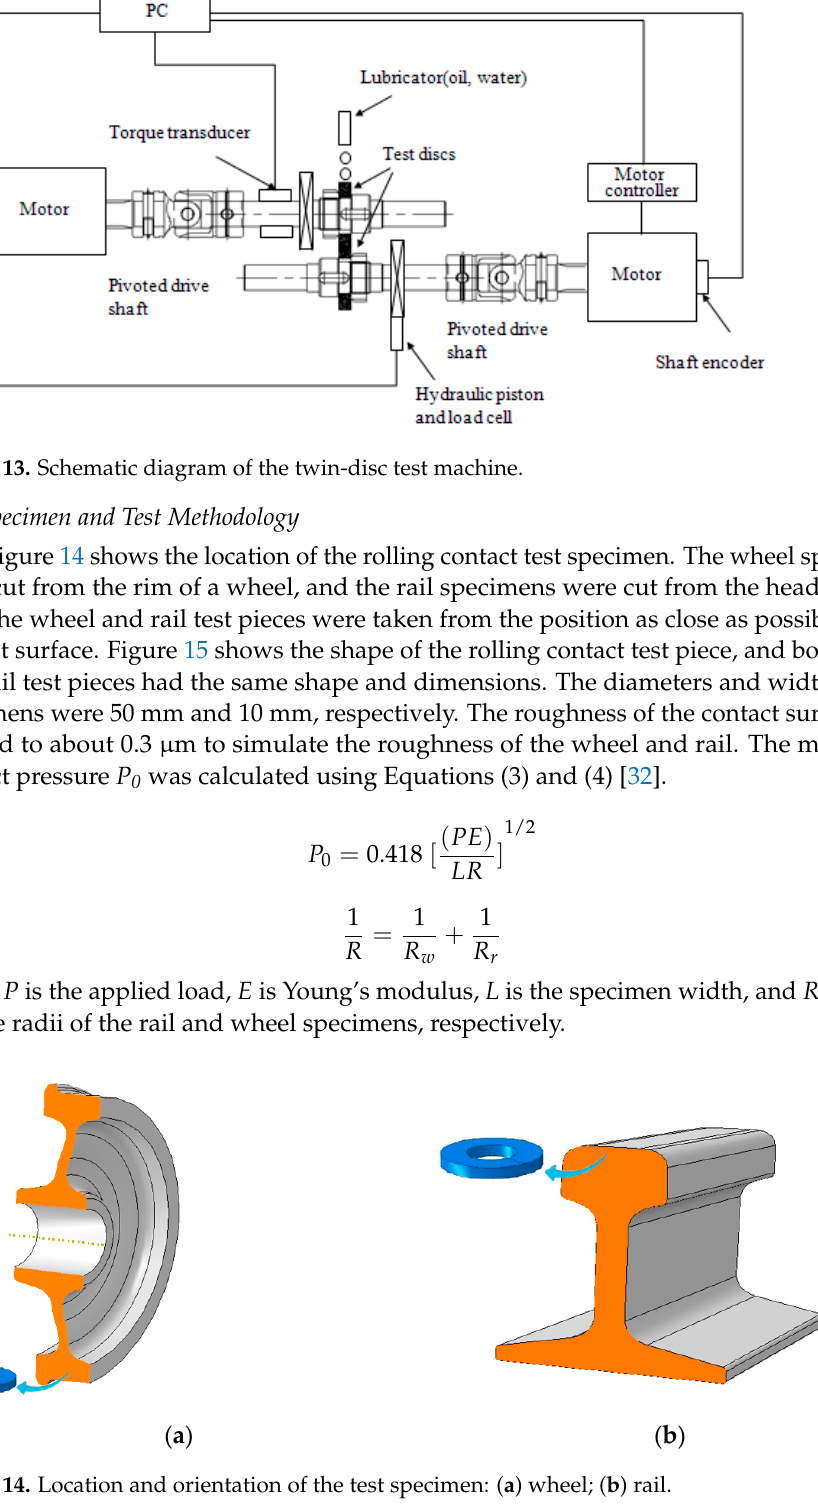
Figure 15. Shape and dimensions of rolling contact specimen. 3.3. Wear Test Results Figure 16 shows the results of the wear test. The wear rate ( μ g/m/mm 2 ) was calcu ‐ lated by dividing the volume of wear loss by the rolling distance and contact area. The RSW ‐ wheel exhibited the largest wear rate, whereas the smallest wear rate was exhibited by the material used for the UIC60 ‐ rail. Both types of test specimens commonly exhibited a larger wear rate in the materials used for the wheel than those used for the rail. This was attributable to the hardness of the rail being higher than that of the wheel. Figure 16. Comparison of wear rate of wheel and rail.